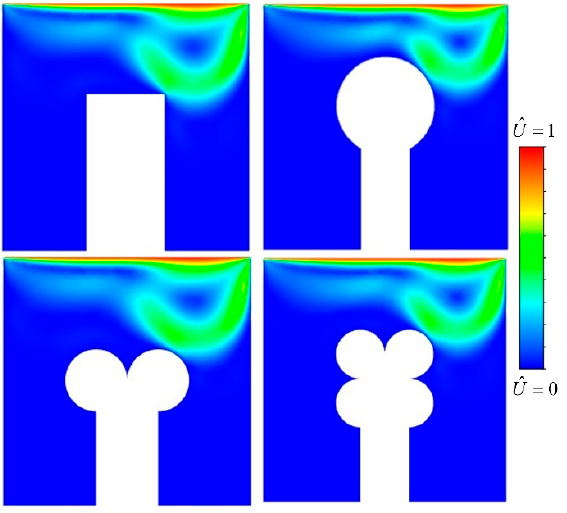
Figure 14. Velocity contours for each of the fins at Re = 1000 and Ra = 10 3 , showing how each fin’s geometry affects fluid flow with a large forcing velocity.